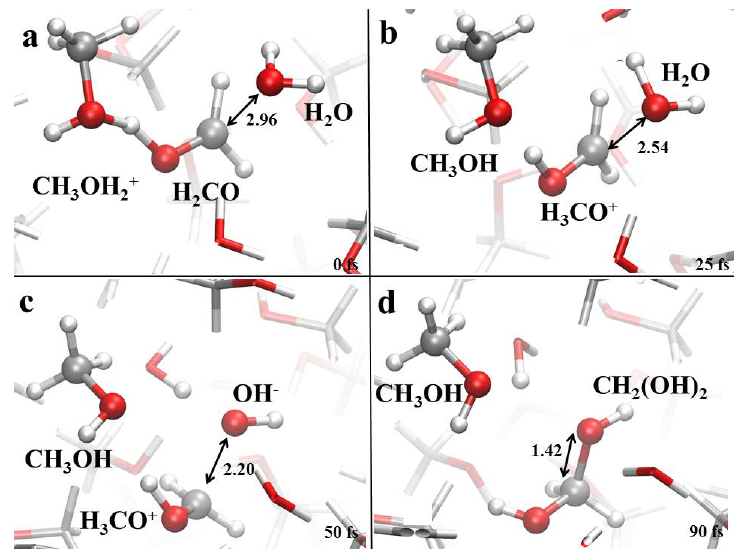
Figure 8. ( a – d ) Formaldehyde monohydrate formation mechanism in neat methanol and in a 75:25 methanol-water mixture under the action of a static electric field of 0.50 V/Å. Table 1. Percent fractions of the molecular species present in the systems at the end of each simulation at 0.50 V/Å and generated by the field. Percentages are determined as the ratio between the number of formed molecules of a given species and the number of methanol molecules composing the original